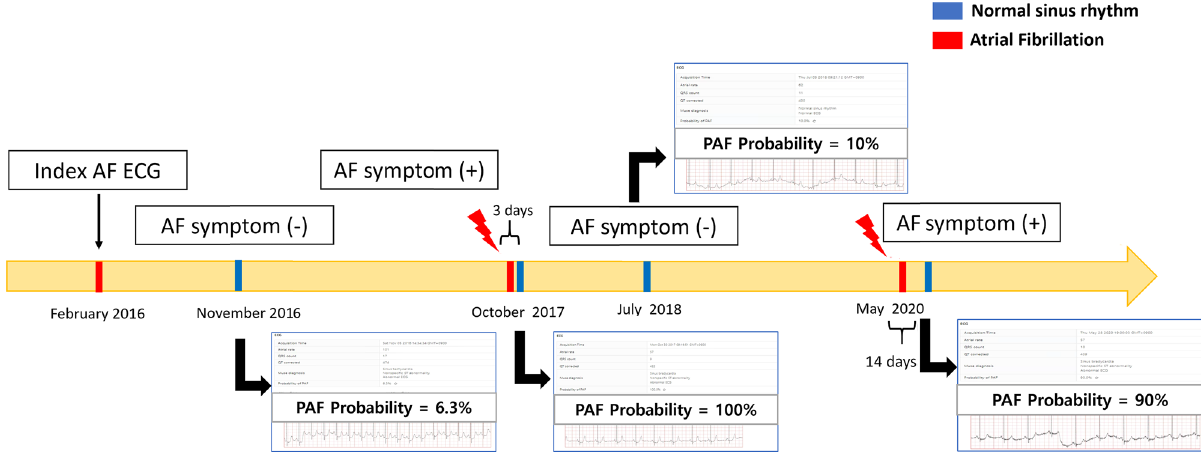
Figure 3. The serial changes of the probability of PAF using AI deep learning algorithm program according to acquired ECG dates. A 72-year-old man diagnosed with PAF is calculated to have AF with probabilities of 90% and 100% by the AI program during normal sinus rhythm, observed after his AF episode had terminated (red lightning bolt). Moreover, he was calculated to have AF with probabilities of 6.3% and 10% when there was no AF symptom. AF symptom is defined as palpitations, fatigue, dizziness, dyspnea, chest pain, and anxiety during AF. AI artificial intelligence; ECG electrocardiogram; NSR normal sinus rhythm; PAF paroxysmal atrial